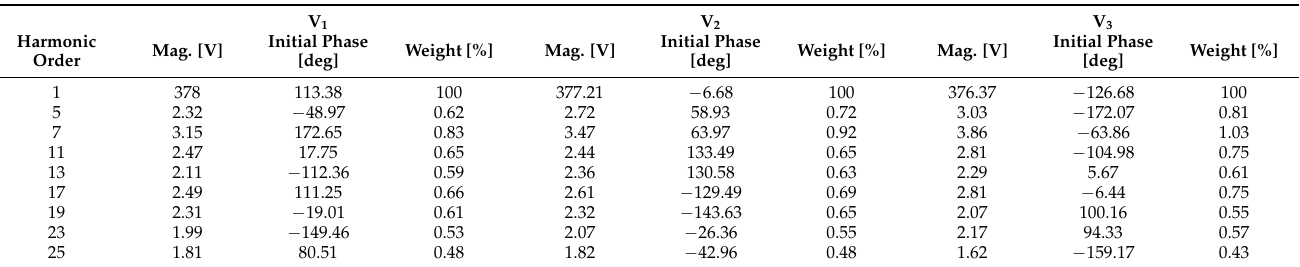
Table 1. Parameters of the most significant harmonics of the phase voltages—before compensa ‐ tion—case γ .